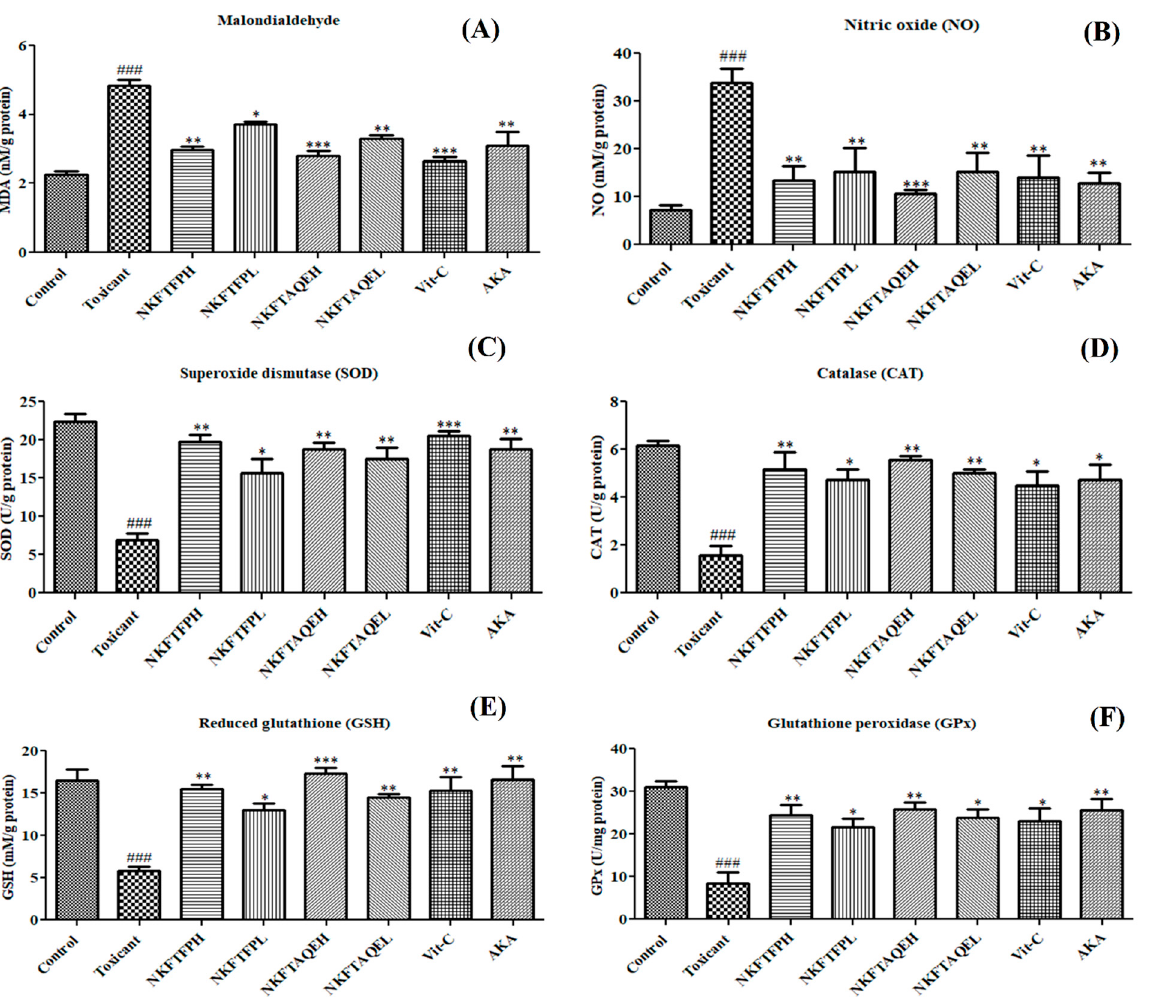
Figure 5. Effect of NKFTFP and NKFTAQE on MOA ( A ), NO ( B ), SOD ( C ), CAT ( D ), GSH ( E ) and GPx ( F ), which were observed against cisplatin-induced oxidative stress in the kidney. The resulting data are expressed statistically as mean ± SD ( n = 6) using one-way ANOVA followed by the Tukey test to compare all pairs of the column. The comparisons are for control to toxic (###) and toxic to drug-treated group (*/**/***). The statistical significance level is expressed at * p < 0.05 (less signifi- cant), ** p < 0.01 (significant) and ###/*** p < 0.001 (high significant). The data represented by ‘*/**/***’ showed statistical difference in the activity as compared to the toxicant group.